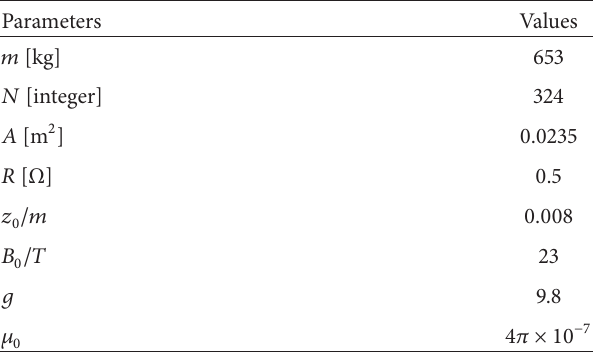
Table 2: Standard maglev bogie parameters of CMS04 maglev